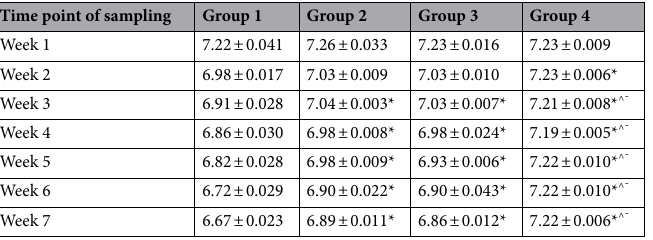
Table 1. Measurement of pH in the media (n = 4) during incubation of bone cores over 7 weeks for four groups, means ±